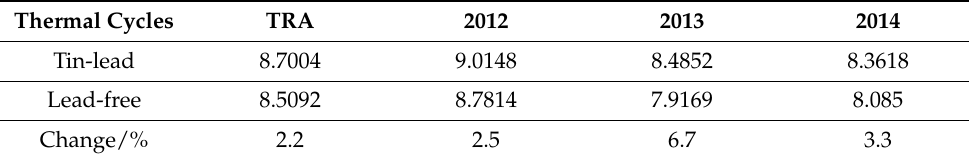
Figure 5. Equivalent von-Mises stress distribution on PbSn solder and Pb-free (Sn 3.8 Ag 0.7 Cu) solder for: ( i ) TRA and ( ii ) 2012 thermal cycles. Table 6. Maximum equivalent von-Mises stress (MPa).